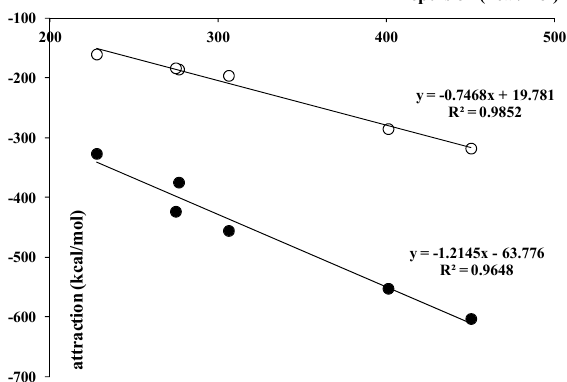
Figure 4. The linear correlations between the Pauli repulsion interaction energy term (kcal / mol) and the sum of attractive terms (kcal / mol, black circles) as well as between this repulsion and the orbital energy (white circles, kcal/mol).